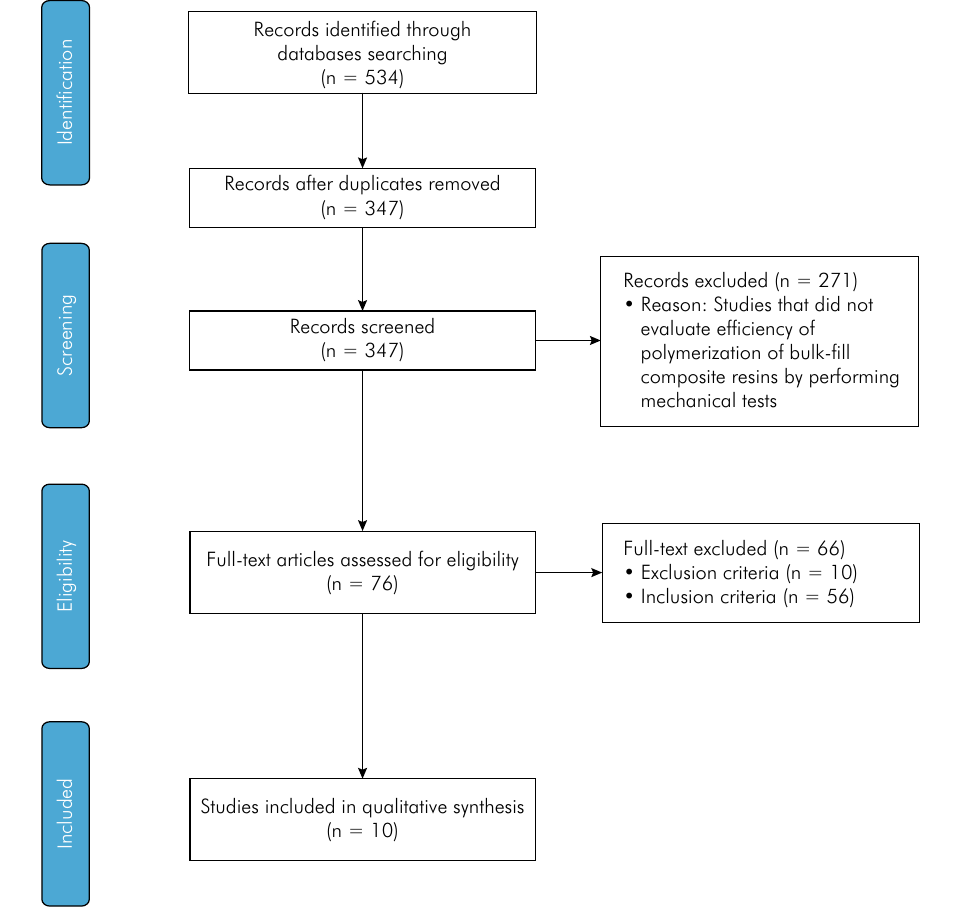
Figure. Flow diagram with an overview of the article-selection